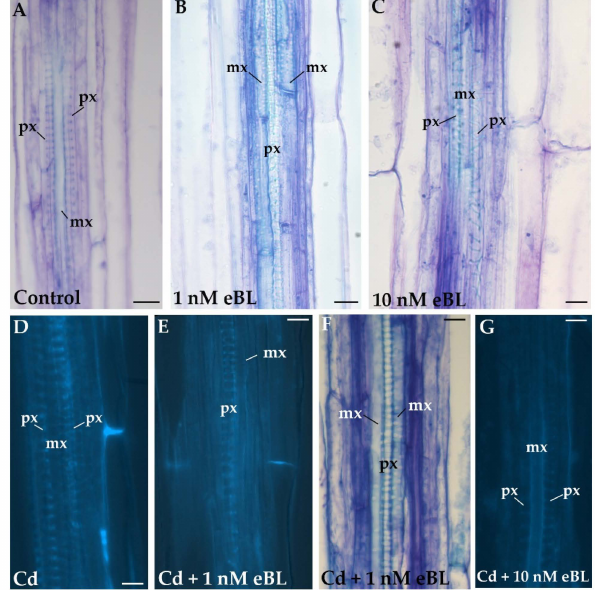
Figure 1. Stelar structure of the basal hypocotyl of A. thaliana (Col ecotype) seedlings cultured for 9 days under continuous darkness followed by 7 days under 16 h light/8 h darkness photoperiod with different treatments. Stelar structure with endarch metaxylem and exarch protoxylem in the control ( A ), in seedlings cultured with 10 nM of 24-epibrassinolide (eBL) ( C ), 60 µ M CdSO 4 (Cd) ( D ), 60 µ M Cd + 10 nM eBL ( G ). The reversal in stelar structure showing exarch metaxylem and endarch protoxylem in seedlings treated with 1 nM eBL ( B ) and 60 µ M Cd + 1 nM eBL ( E , F ). Light microscopy images of radial longitudinal sections stained with toluidine blue ( A – C , F ) or visualized in fluorescence to detect lignin (bright blue color) ( D , E , G ). mx, metaxylem; px, protoxylem. Bars = 10 µ